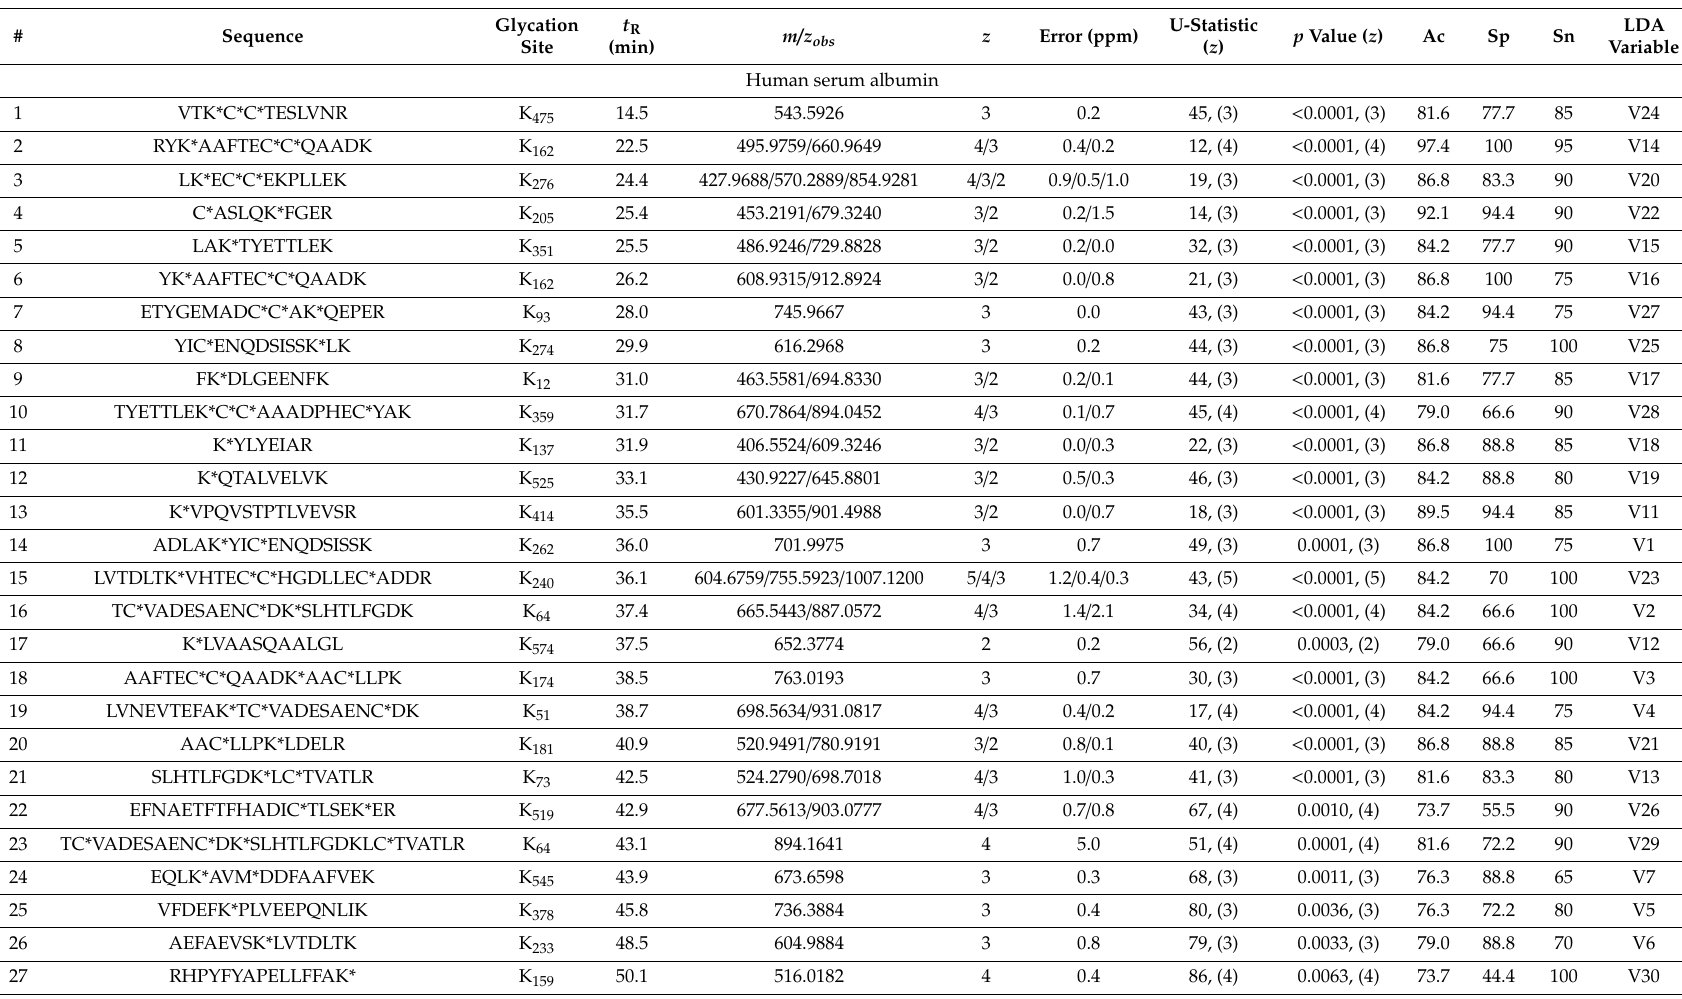
Table 1. Individual glycated peptides di ff erentially abundant in tryptic digests obtained from the T2DM patients and individuals without